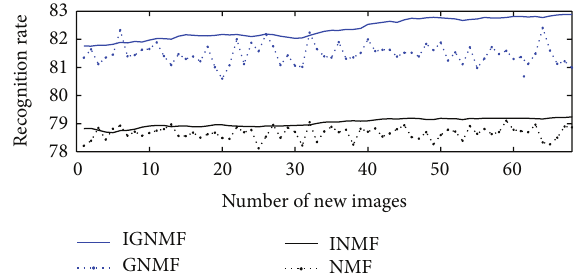
Figure 4: The average recognition rate during incremental study for the CMU-PIE